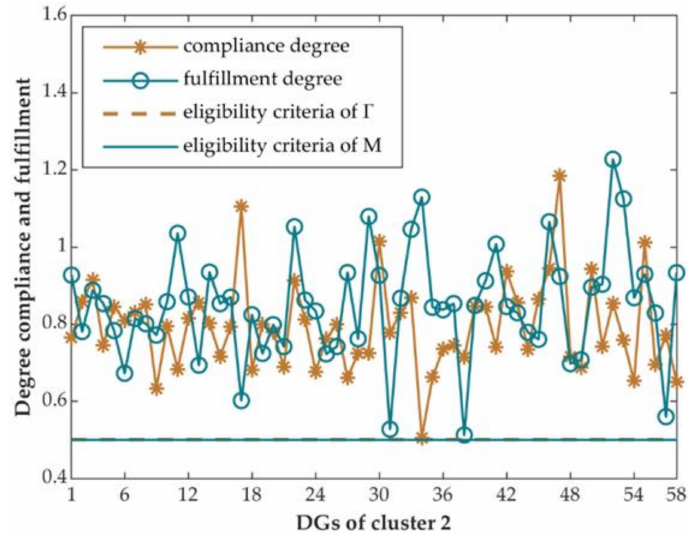
Figure 9. Degree of compliance and fulfillment in cluster 2.